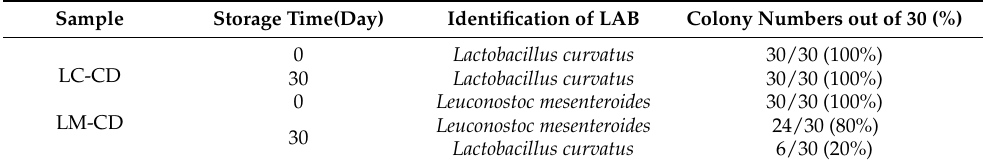
Table 4. Microbial community of lactic acid bacteria of LC-CD and LM-CD during 30 days at 10 ◦